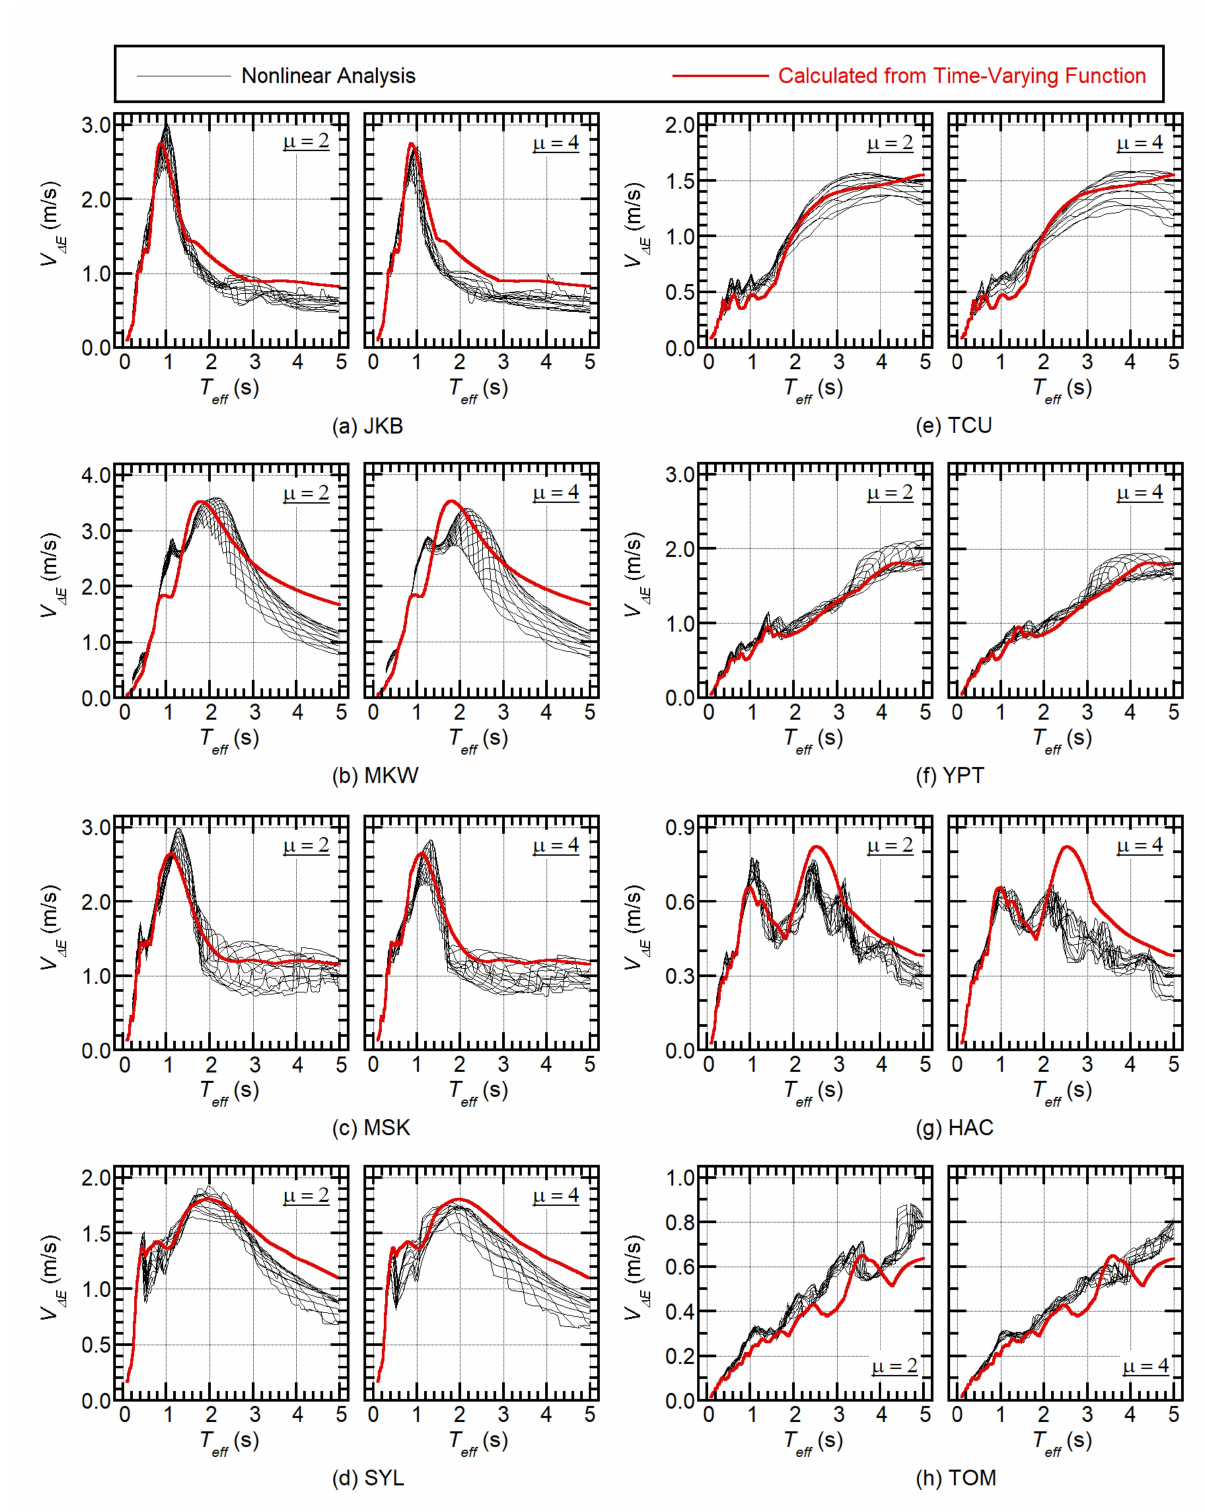
Figure 8. Evaluation of maximum momentary input energy spectrum for each ground acceleration